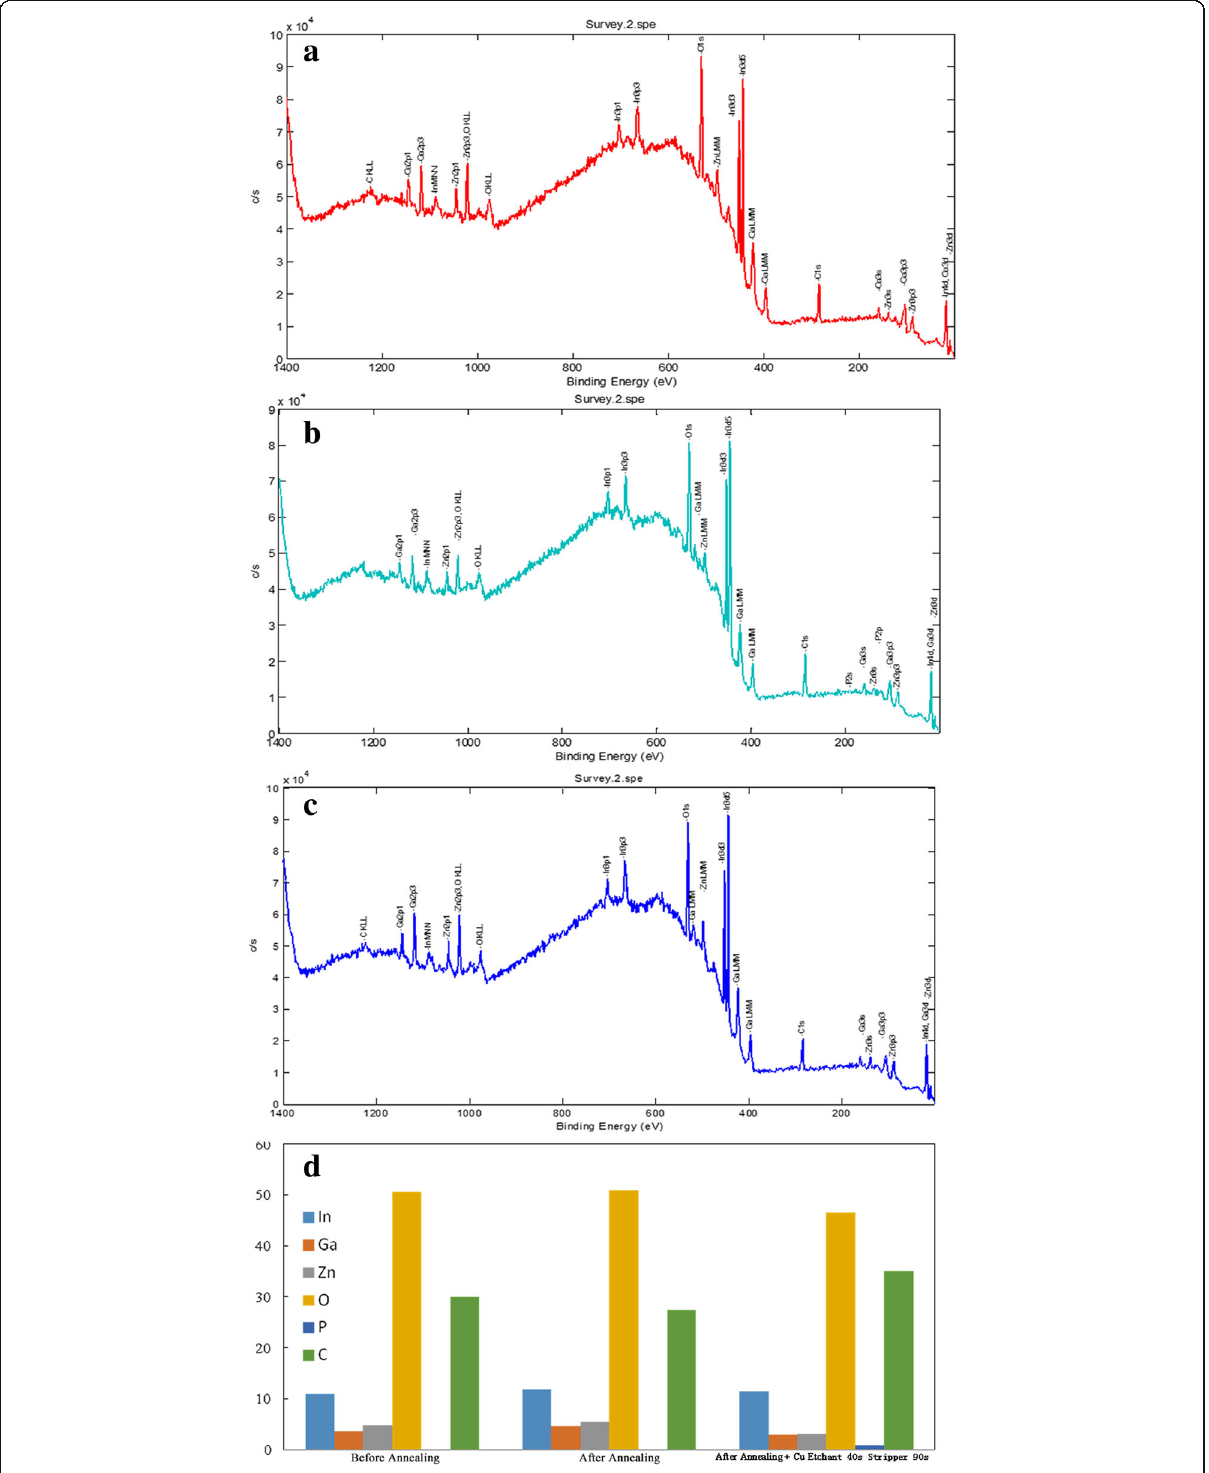
Fig. 4 XPS analysis of the surface composition of the a-IGZO thin films a before annealing, b after annealing, and c after exposure to the H 2 O 2 Cu etchant during the BCE process. d Corresponding atomic percentages for the above